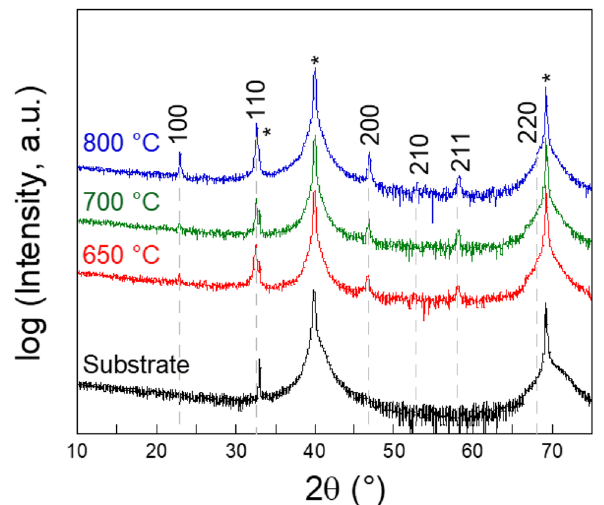
Fig. 2 XRD data for 210 nm 0.8BNT–0.2BKT films annealed at 1 min, 5 min, and 10 min at 700 °C with present BNKT peaks labeled (Sub- strate peaks are marked by a *